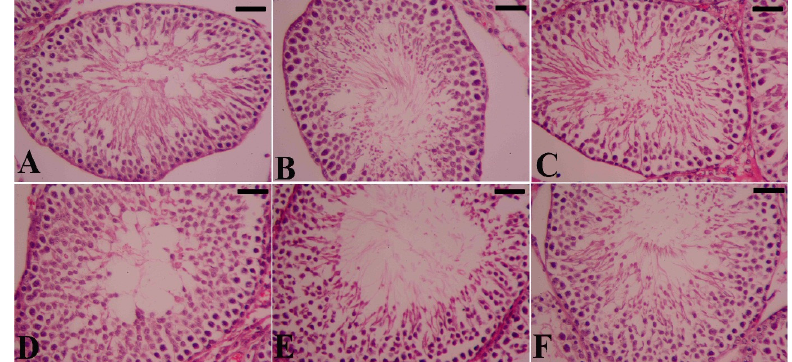
Figure 7. Impact of SeNPs and/or insulin on the histology of the testis in diabetic rats. ( A ) control rats; showing typical testicular architecture; ( B ) SeNPs-treated rats; showing typical spermatogenic cells in the seminiferous tubules; ( C ) STZ-diabetic rats; showing severe testicular damage; ( D – F ) STZ-SeNPs-treated group, STZ-Ins-treated rats and STZ-SeNPs-Ins-treated rats, respectively; SeNPs and/or insulin ameliorated the defects of the spermatogenic cells in the seminiferous tubules caused by diabetes. Tissues were stained with haematoxylin and eosin. Scale bar = 50 μ m.